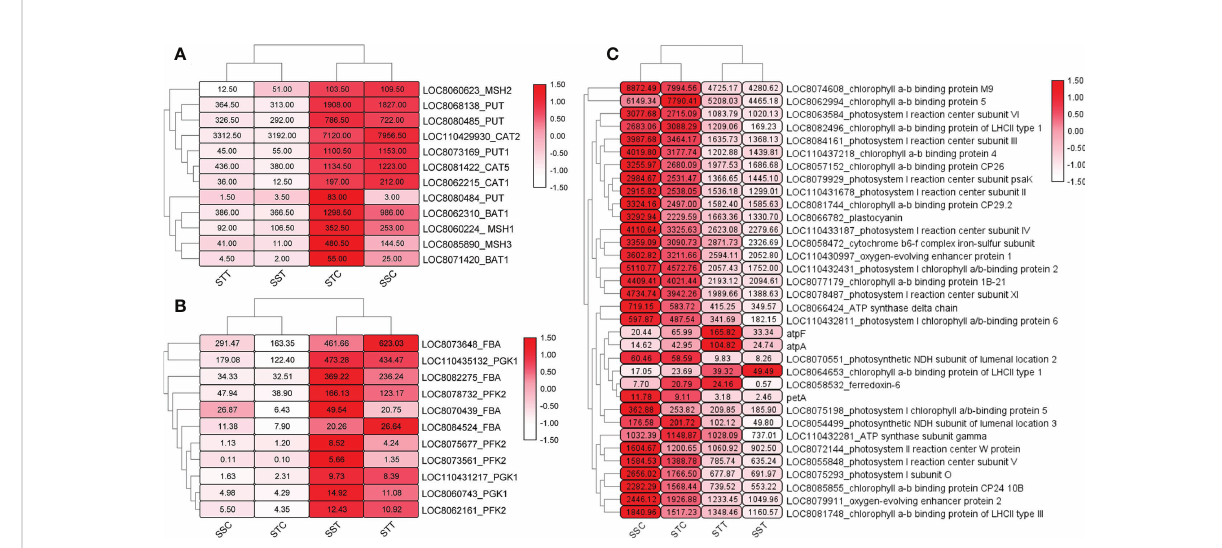
FIGURE 3 Heatmap of differently expressed genes (DEGs) in candidate pathways. The redder and larger the circle, the higher the expression. (A) Expression of DEGs in carbohydrate catabolic process. (B) Expression pattern of transcripts of SbCAT, SbPUT, SbMSH, and SbBAT. (C) Expression of DEGs related to